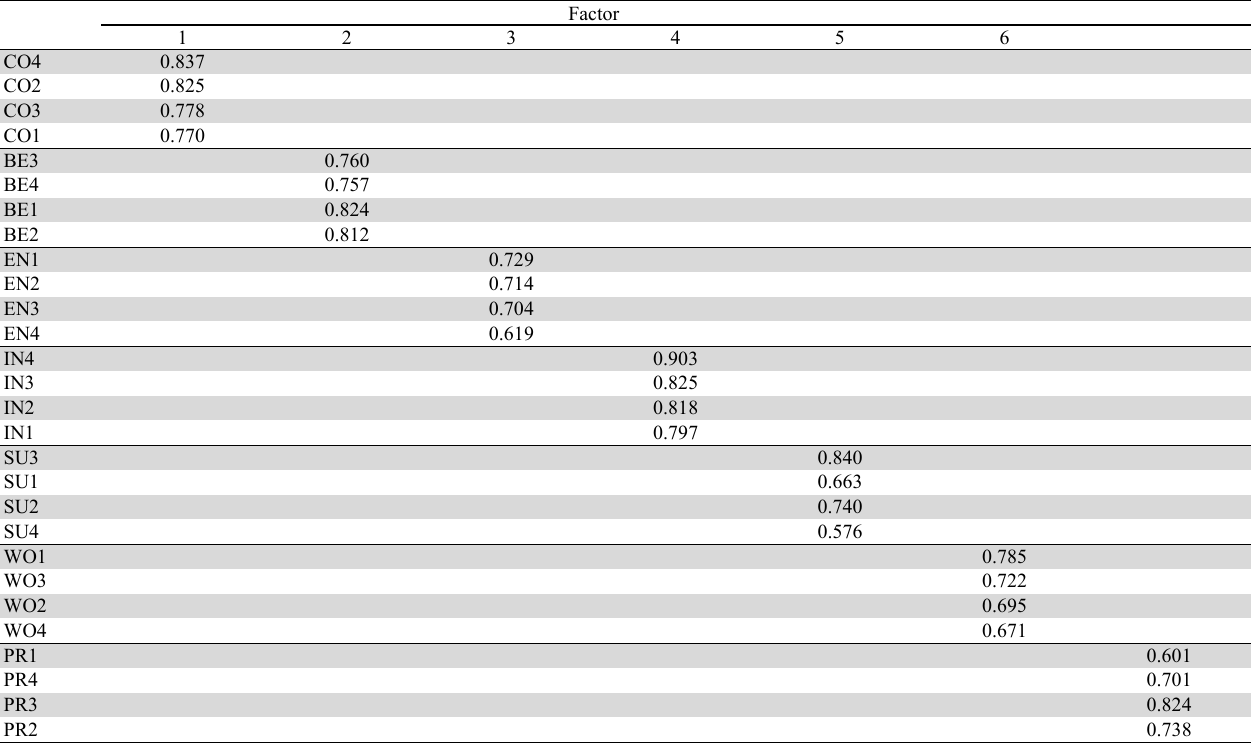
Results of factor analysis to discover EFA independent variables